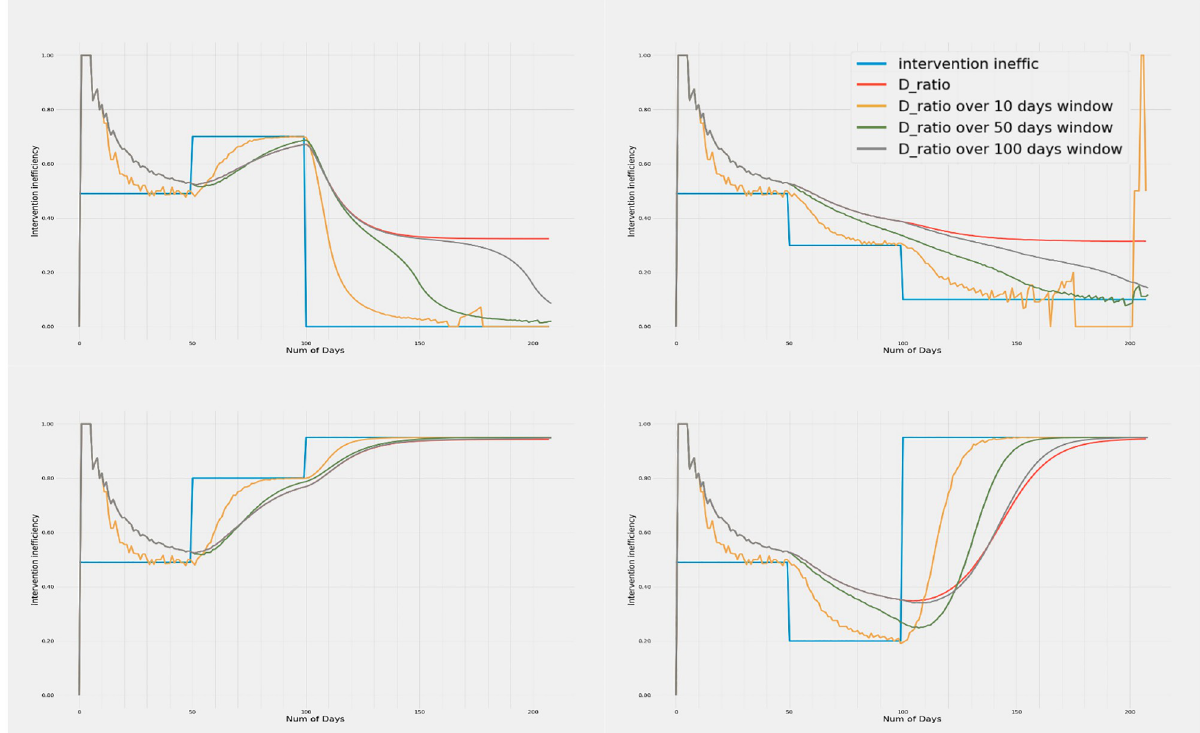
Fig 2. Variation of intervention inefficiency and D smooth ratio with time. The 4 plots show the trends in D ratio over window periods of 10, 50 and 100 days when the inefficiencies are increased and decreased in different temporal orders. Metrics calculated with all window sizes show high day to day variation when the death numbers in either arm is very low. However, metrics with smaller window sizes are more prone to this daily variation. It is observed that D ratio when smoothed over a small window of 10 days, converges faster but has a lot of variance due to daily fluctuations in numbers. Whereas D ratio over a 100 days window length is smoother, but takes longer to make inferences due to slower convergence. Although sensitive to noise, 10 day window period gives the fastest convergence followed by 50 and 100 day